Question: State the chart type depicted above.
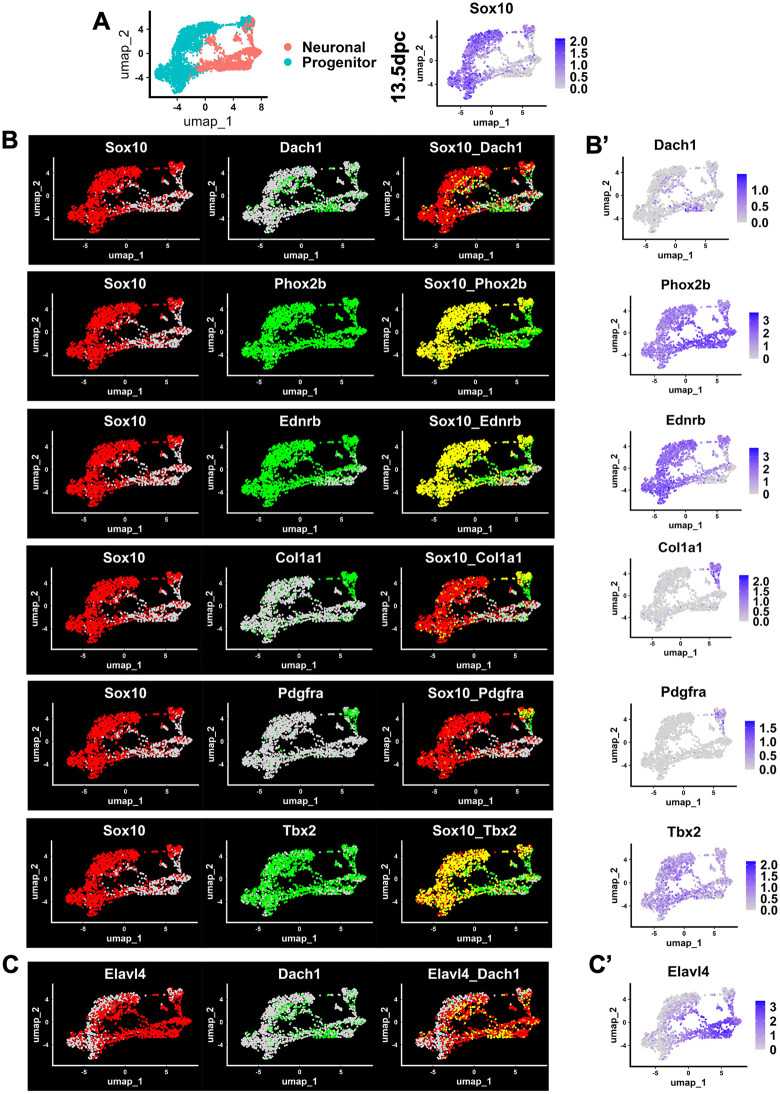
Answer: scatter